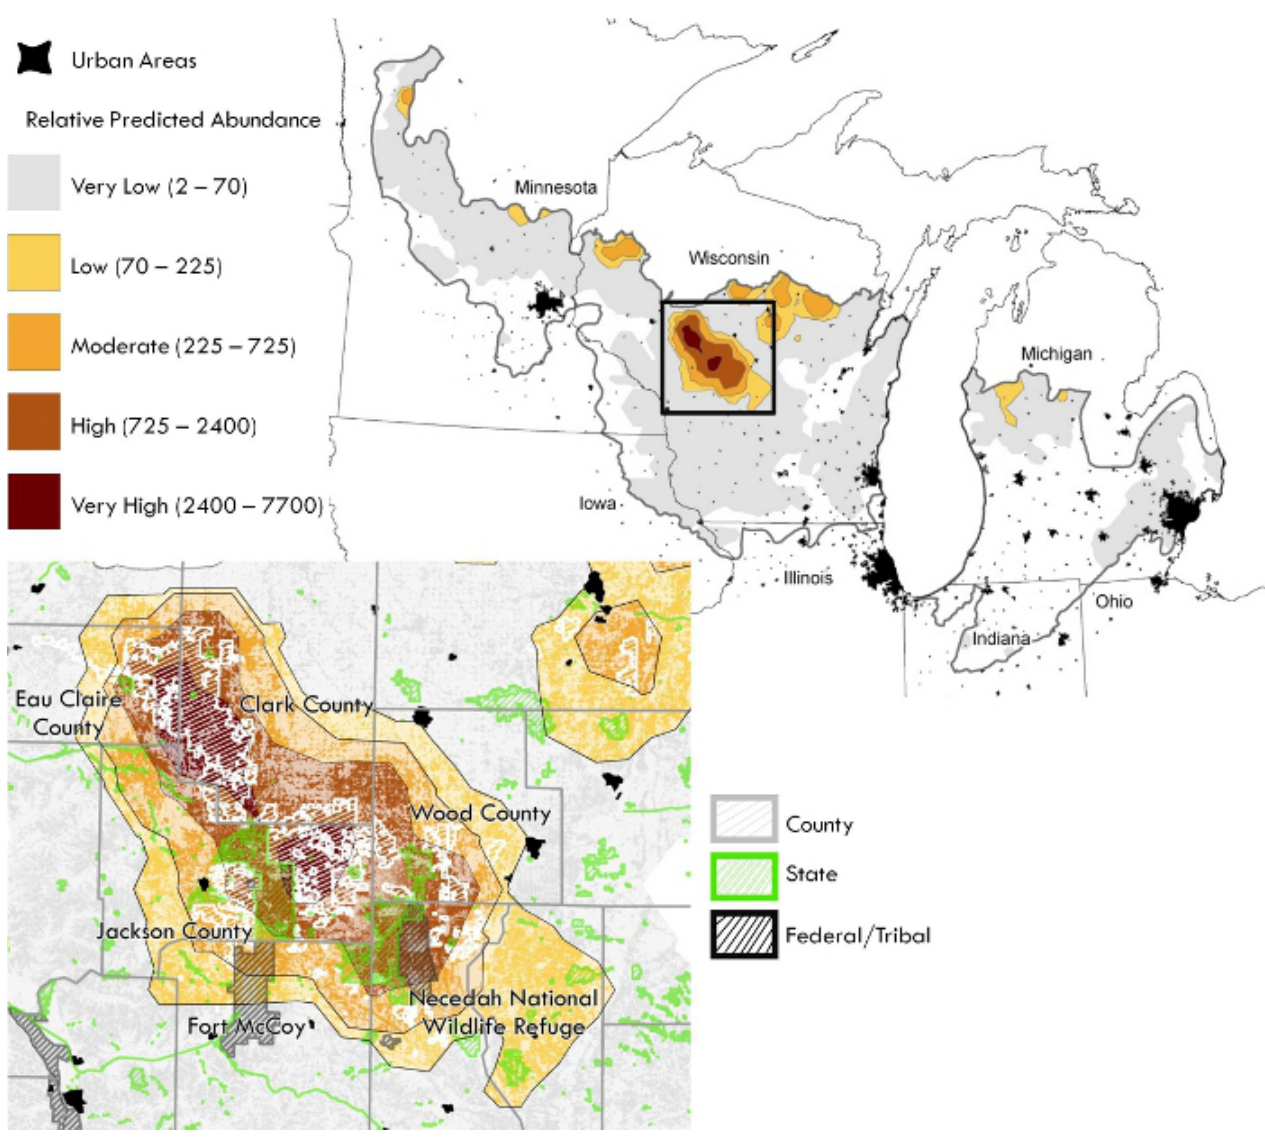
Fig. 3. Map of predicted relative abundance (birds × 100 predicted per survey) for the Golden-winged Warbler ( Vermivora chrysoptera ) in the Prairie Hardwood Transition of the upper midwestern United States. The primary peak of predicted abundance for Golden-winged Warblers occurs in west-central Wisconsin